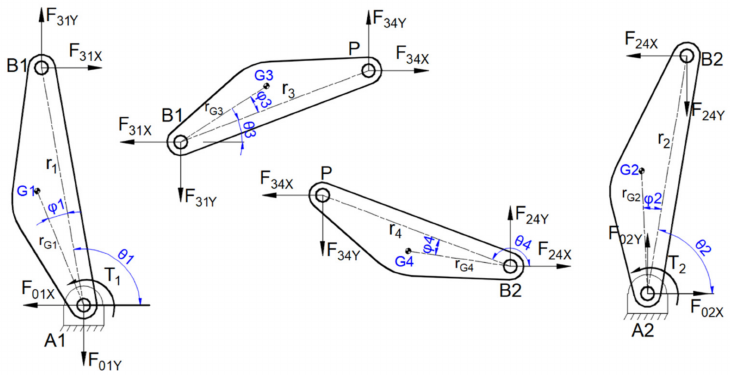
Figure 3. Free body diagrams of the five-bar planar